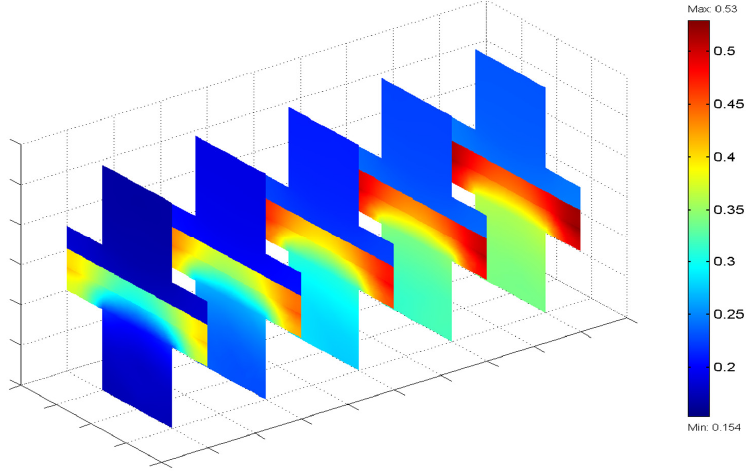
Figure 13. Variation of water molar fraction within the cell at peak power.